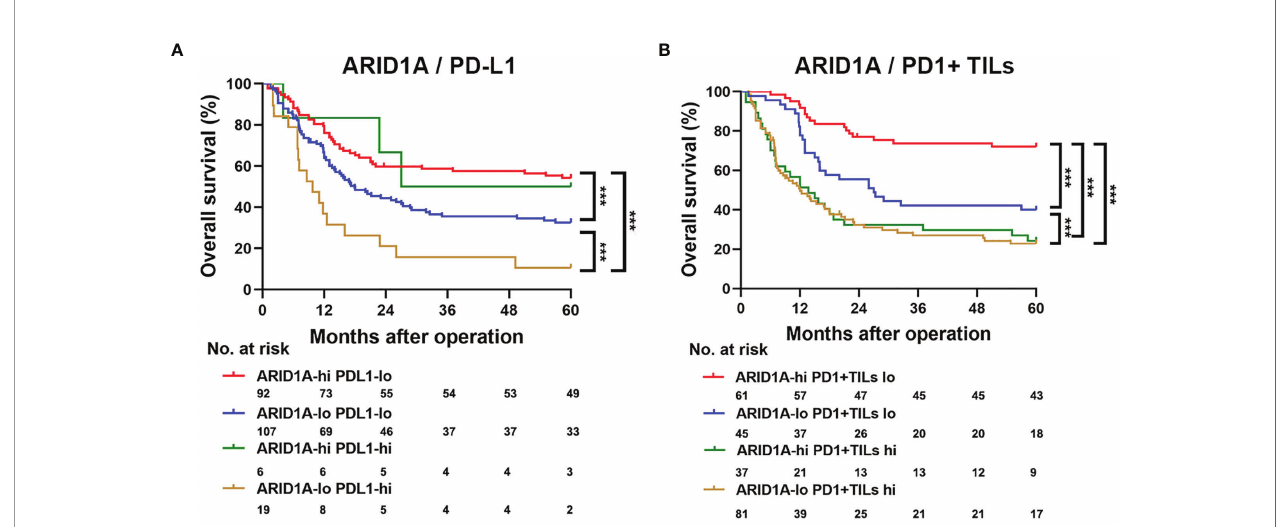
FIGURE 4 | Kaplan – Meier survival analysis of overall survival (OS) according to AT-rich interactive domain 1A (ARID1A) expression, PD-L1 expression, and PD1+ tumor-in fi ltrating lymphocyte (TIL) counts. (A) Kaplan – Meier survival analysis of OS in patients with gallbladder cancer based on ARID1A expression and PD1+ TIL